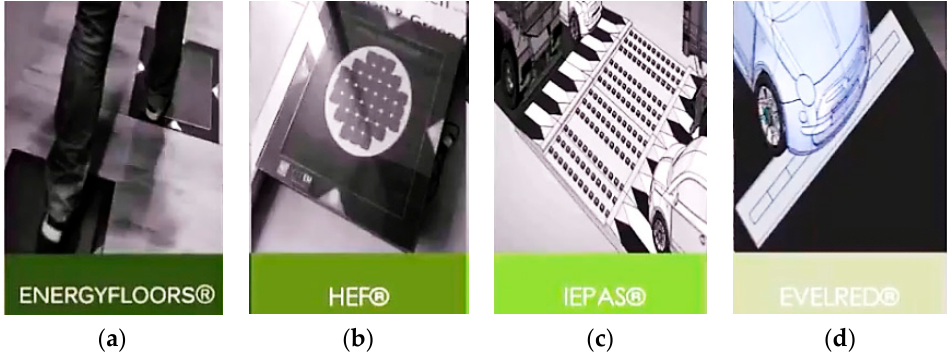
Figure 35. Different OTEM2000 ′ s products: EnergyFloors ® solution to recover energy from the per- son's footsteps ( a ), example of HEF ® tile ( b ); IEPAS ® ( c ) and EVELRED ® real applications to recover energy from car transit ( d ) [82].